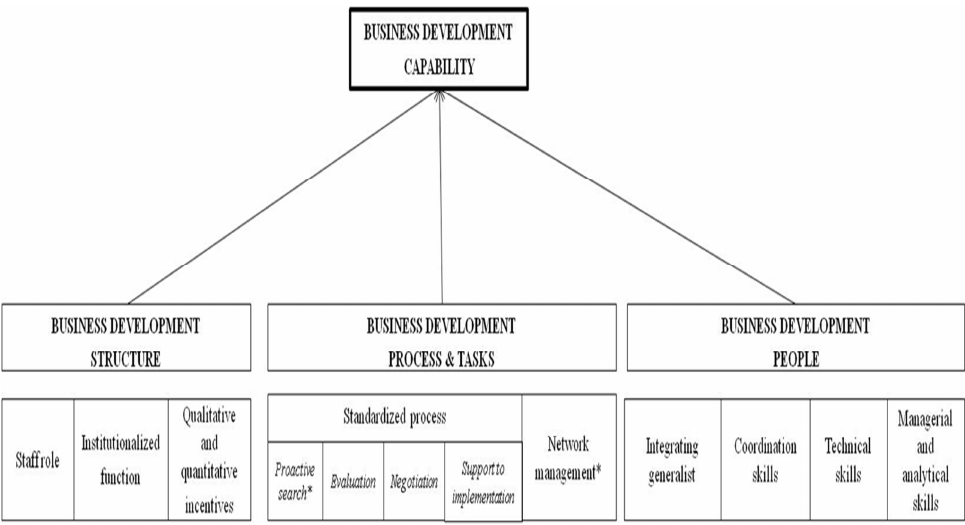
Figure 2: Main Elements of a Business Development